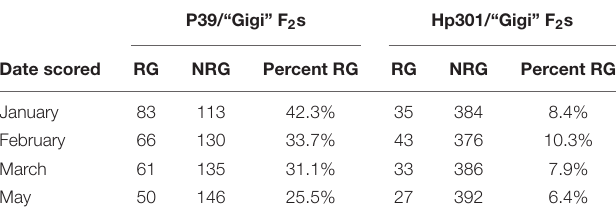
TABLE 3 | Numbers of regrown (RG) and non-regrown (NRG) plants in F 2 populations scored during different time points following flowering and senescence in